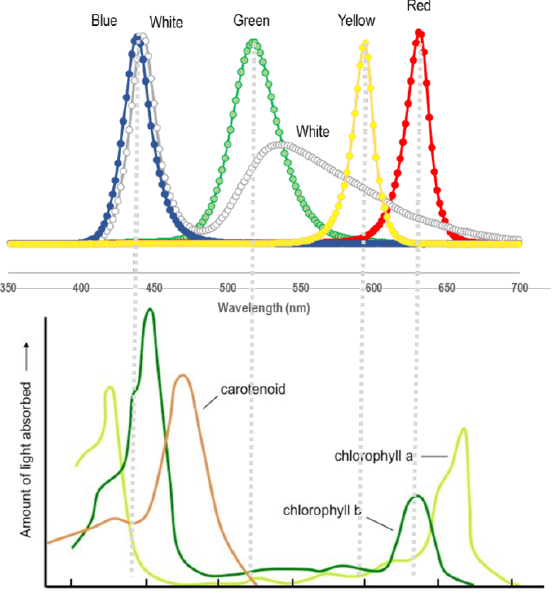
Figure A1. Experimental configuration for growing A. protethecoides with monochromatic illumi- nation by LEDs in 500 mL flasks aerated with sterilized air.